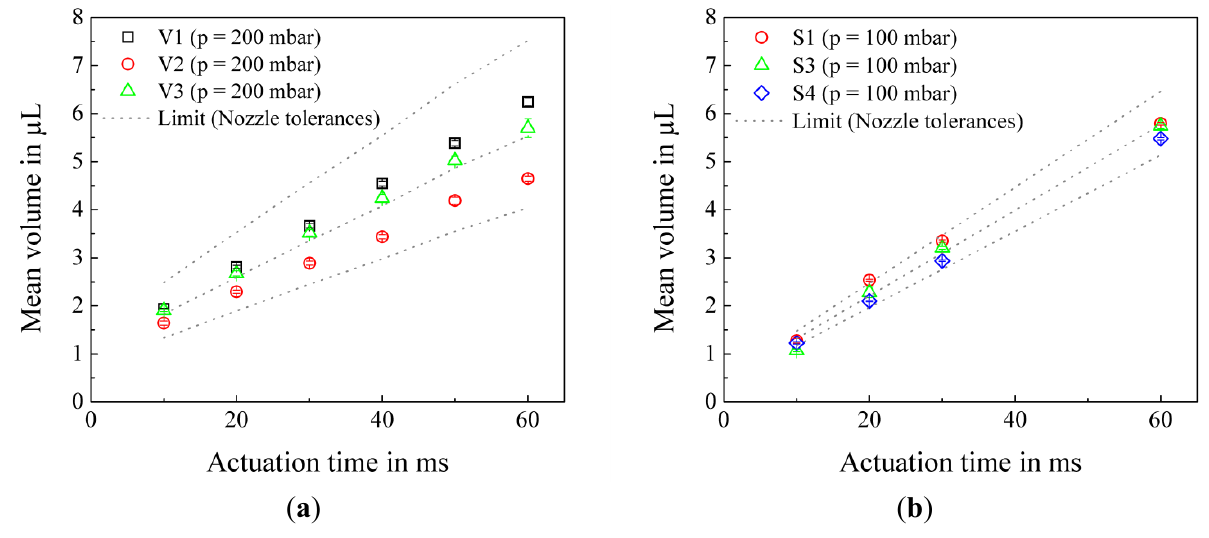
Figure 9. Each data point states the mean volume of 24 dispenses. The inner dashed line is the linear fit to all data points, the outer dashed lines show the maximum respectively minimum volume calculated for the largest respectively smallest possible nozzles according to the given tolerances of the capillaries ( a ) Dosing performance of three valves with a steel capillary as nozzle. ( b ) Dosing performance of the injection molded valve with PI capillaries. Properties of these valves are listed in Table